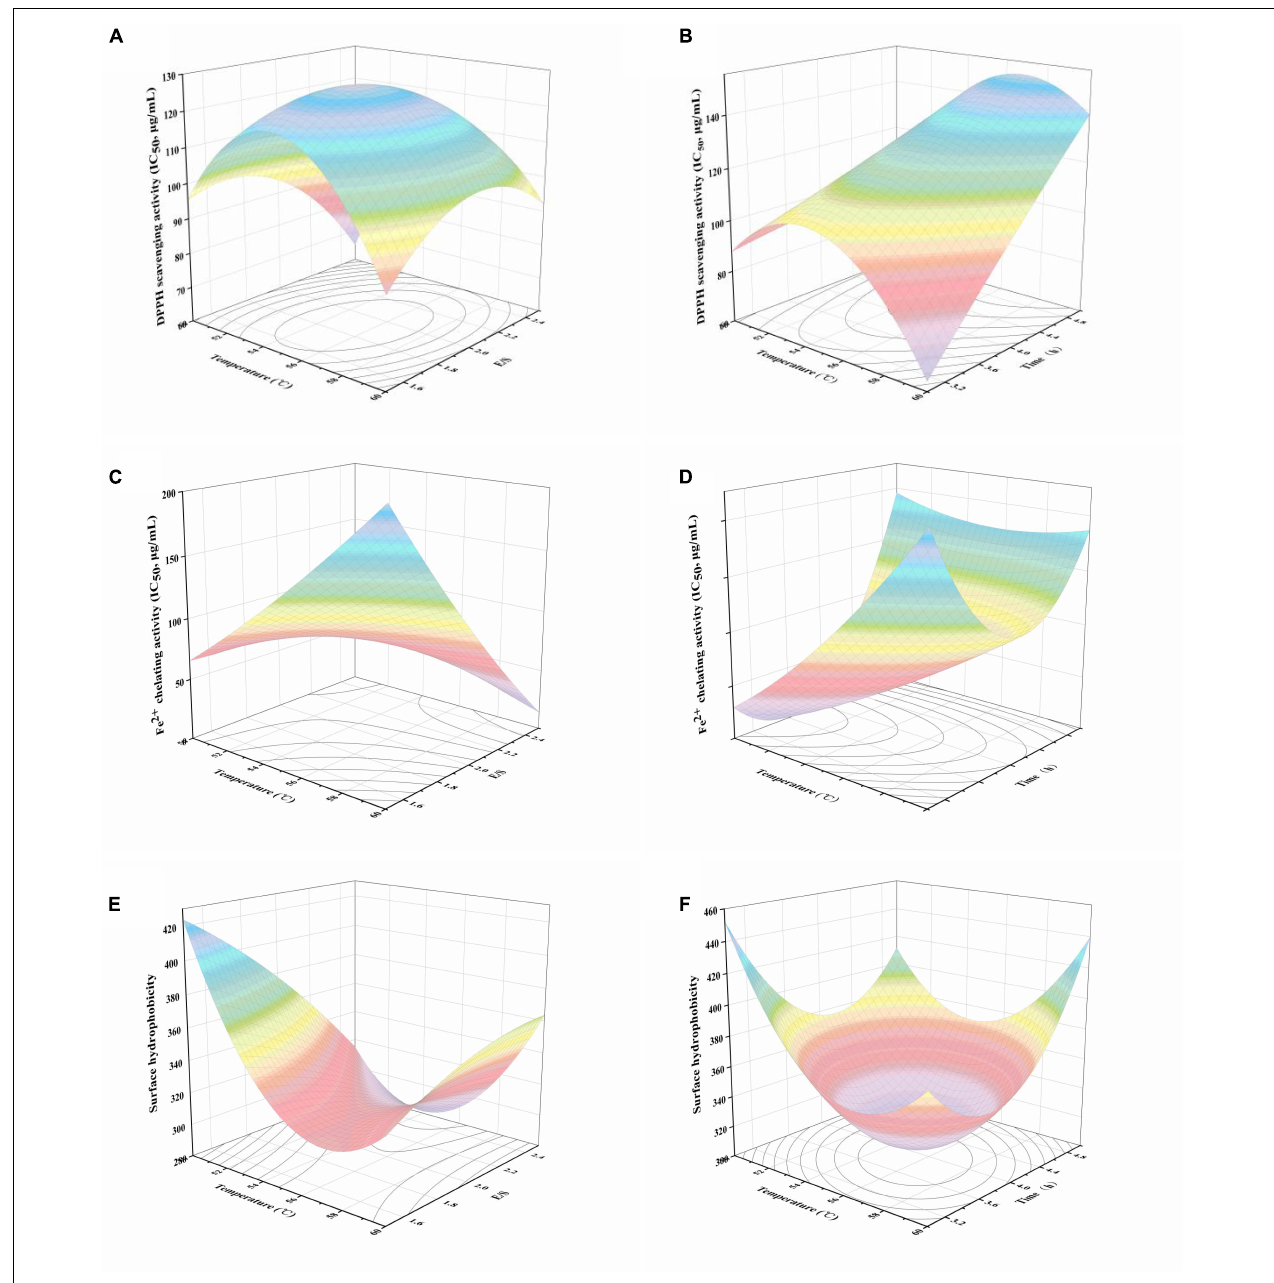
FIGURE 1 | Response surface plots of the effects of temperature and E/S, temperature and time on DPPH radical scavenging activity (A,B) , Fe 2 + chelating activity (C,D) and surface hydrophobicity values (E,F) of black bean protein